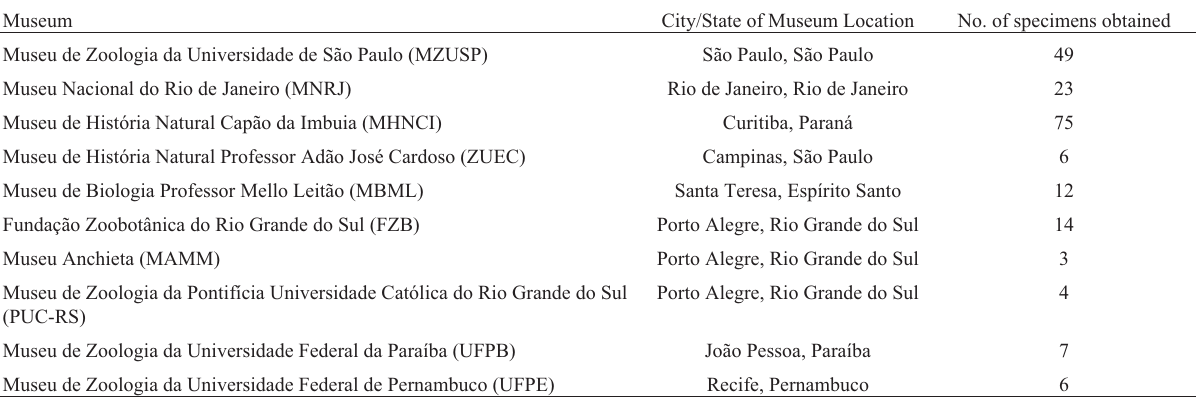
Table 1 - The natural history collections visited, their respective acronyms, locations and number of turbinate bones